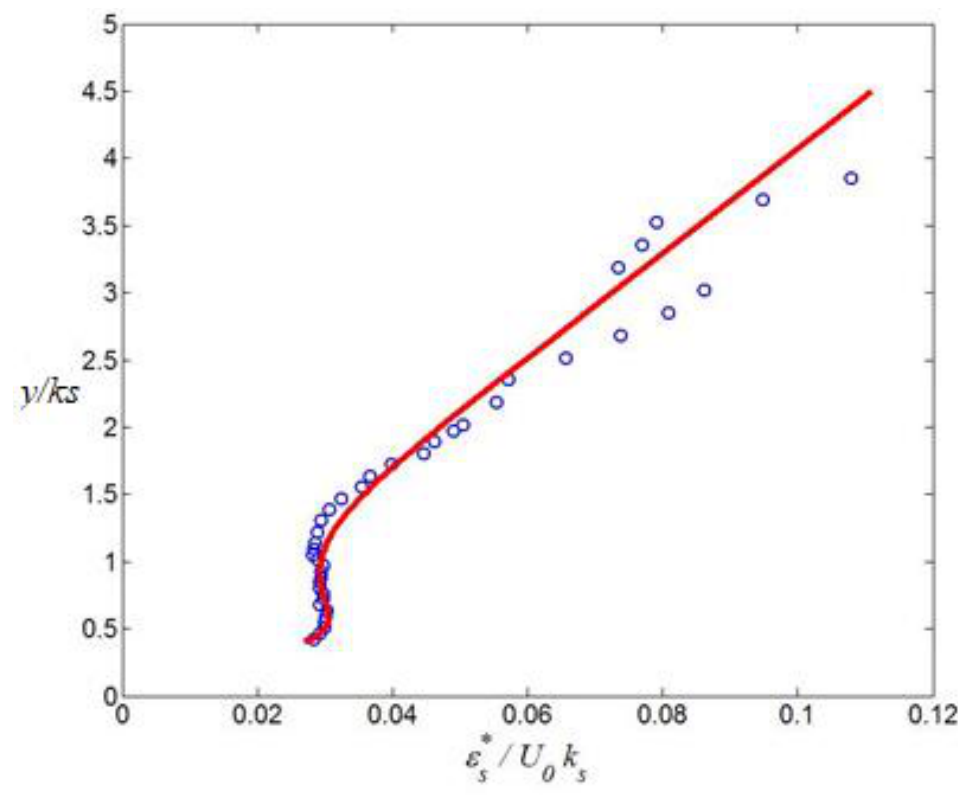
Figure 12. Normalized apparent sediment diffusivity over ripples with steep slopes for medium sediments, symbols: experimental data, curve: calculation from Equation (34) with 𝐴 𝑠 = 0.026 , 𝑦 0 /𝑘 𝑠 = 0.2 s , 𝐵 𝑠 /𝑘 𝑠 = 500 , 𝐷 =9, and ℎ 𝑠 /𝑘 𝑠 = 0.26 .